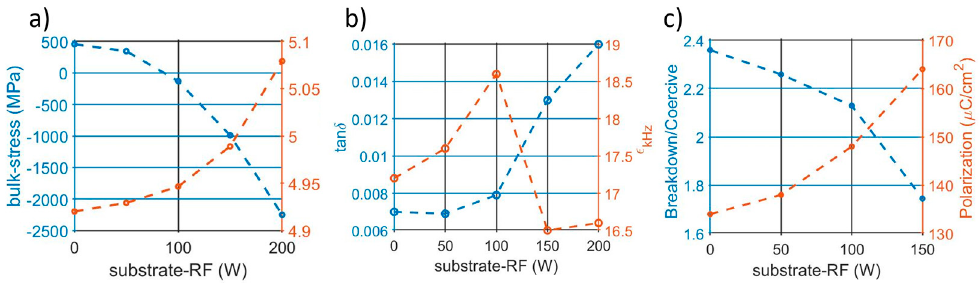
Figure 9. ( a ) Substrate-RF-induced variation of the residual stress extracted from the Flexus measurement and on the c-axis dimension extracted from the XRD scan [40]. ( b ) 5 kHz tan δ and dielectric permittivity of the pristine capacitors. ( c ) Breakdown/coercive field ratio and polarization variation per different substrate-RF.